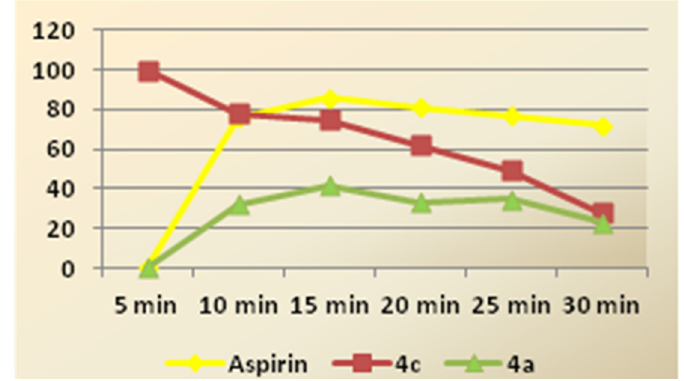
Figure 3. % Anti-nociception measured every 5 min for 4a , 4c and aspirin .